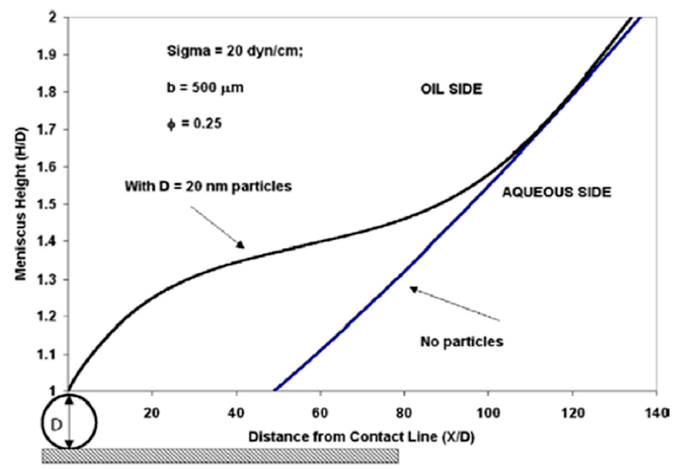
Figure 5. The simulated shape of the meniscus profile in the wedge region [21].